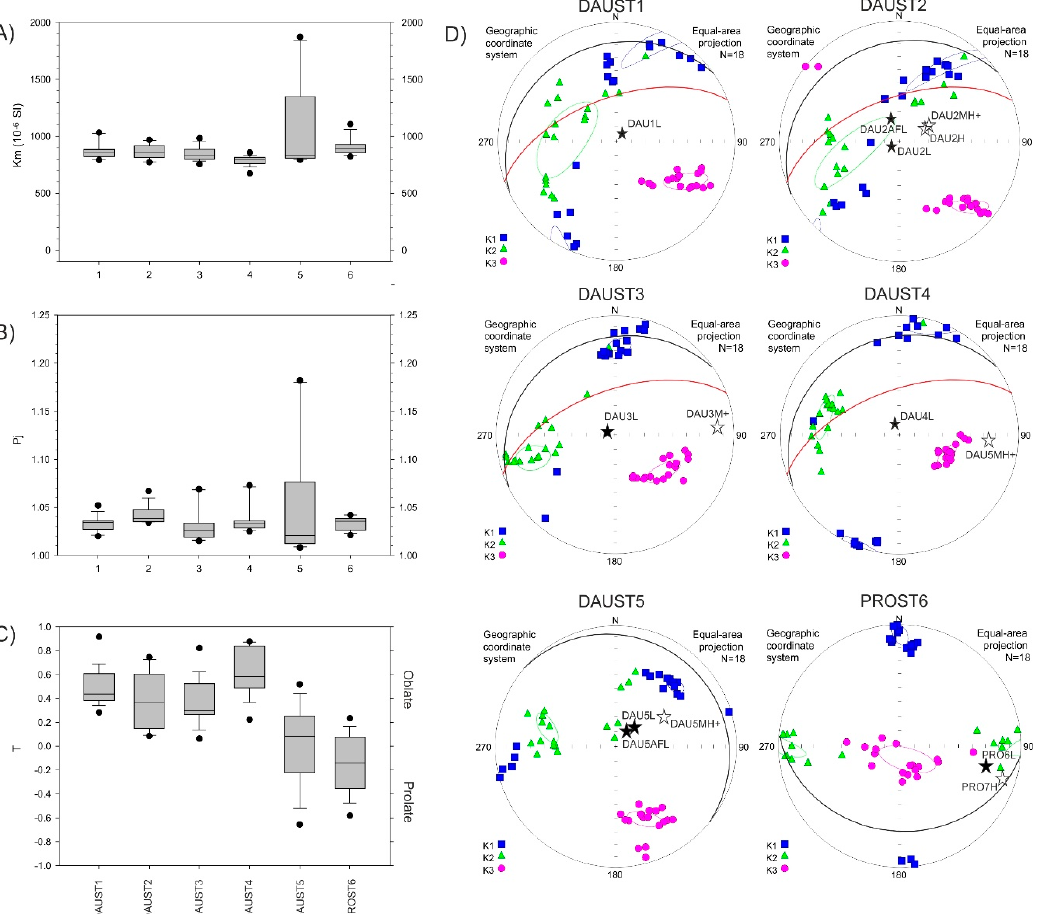
Figure A1. The results of anisotropy of magnetic susceptibility (AMS) experiments of metadolerites and metacarbonates rocks from SW Oscar II Land; ( A ) diagram of the mean magnetic susceptibility (Km); ( B ) diagram of corrected anisotropy degree (Pj) sensu Jelinek [65] ( C ) diagram of the shape parameter (T); grey boxes—25% and 75% percentiles; horizontal lines inside boxes- the mean values; black dots- maximum and minimum values; vertical lines (whiskers)—10% and 90% percentiles ( D ) Equal-area projections of principal susceptibility axes; points K1, K2, K3 represents maximum, intermediate and minimum axes respectively with α 95 confidence ellipses for each population. Lower-hemisphere—filled symbols; upper hemisphere—open symbol. Orientations of all calculated palaeomagnetic components are marked by stars. The parameters of the host metacarbonates bedding and cleavage are marked by black and red arcs respectively.